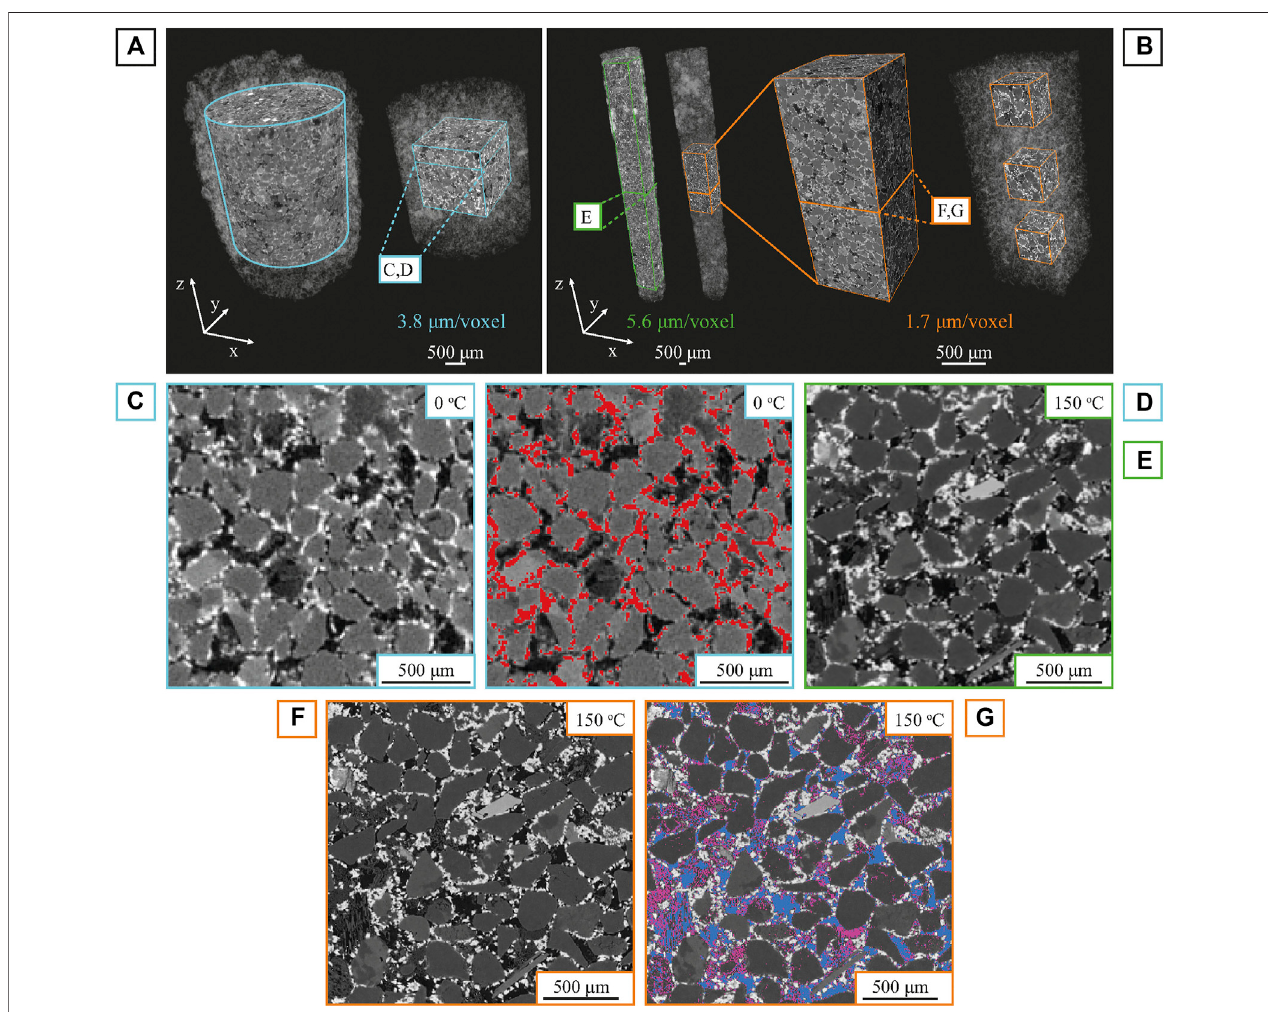
FIGURE1| Multi-scale XCTanalysis. (A) 3DVolumerenderingofthecylindricalandcubicsubvolumes extracted fromsamplesS1-S5scannedwitharesolutionof 3.8 μ m/voxel (outlined in light blue). (B) 3D volume renders of sample S6 divided into S6A, S6B and S6C1-C3 based resolution and volume size. S6A is scanned with a resolutionof5.57 μ m/voxel(outlined in green),whereas subsectionS6Band subsequent cubicsubvolumesS6C1 (top),S6C2 (middle) and S6C3 (bottom) arescanned with aresolution of 1.7 μ m/voxel (outlined in orange). (C) 2D slice through the tomography data showing the gray scale image before the experiments. (D) 2D slice showingthegraincoatingphase(red)beforetheexperiments. (E,F) 2Dregisteredslicesfromdatacollectedatdifferentresolutions(e.g.,sampleS6AandS6Bafterbeing hydrothermally treated up to 150 ° C). (G) Selection of the macropore (blue) and microporous (purple) volume phases.